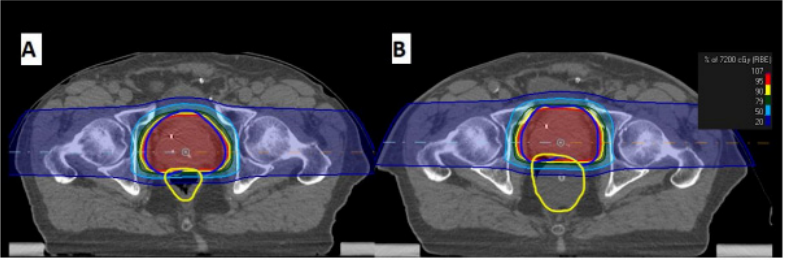
Figure 1. Example of IMPT dose distribution for cT2N0M0 Prostate cancer patient. ( A ) non-ERB plan. ( B ) ERB plan.